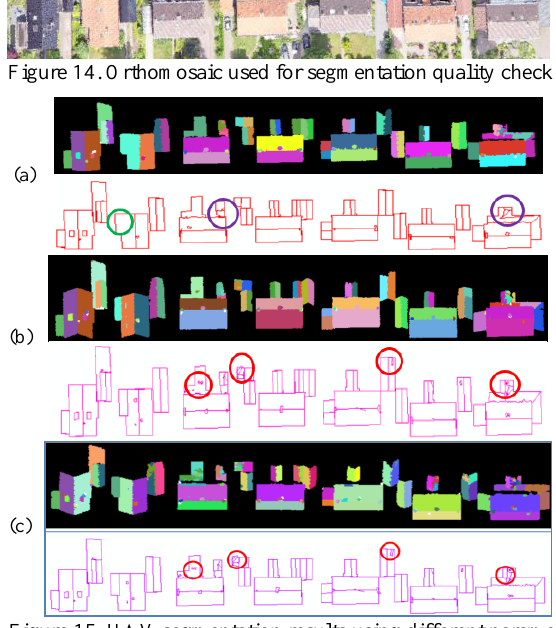
Figure 15. UAV segmentation results using different parameters